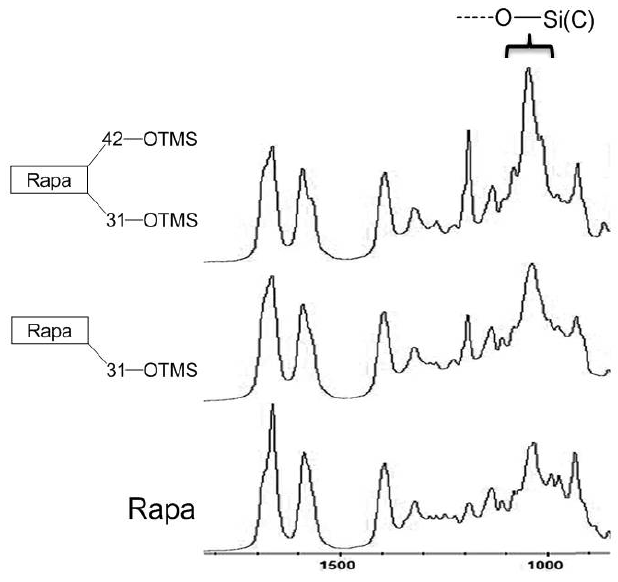
Figure 2. Expanded solid state FT-IR spectra for Rapa, Rapa-31-OTMS and